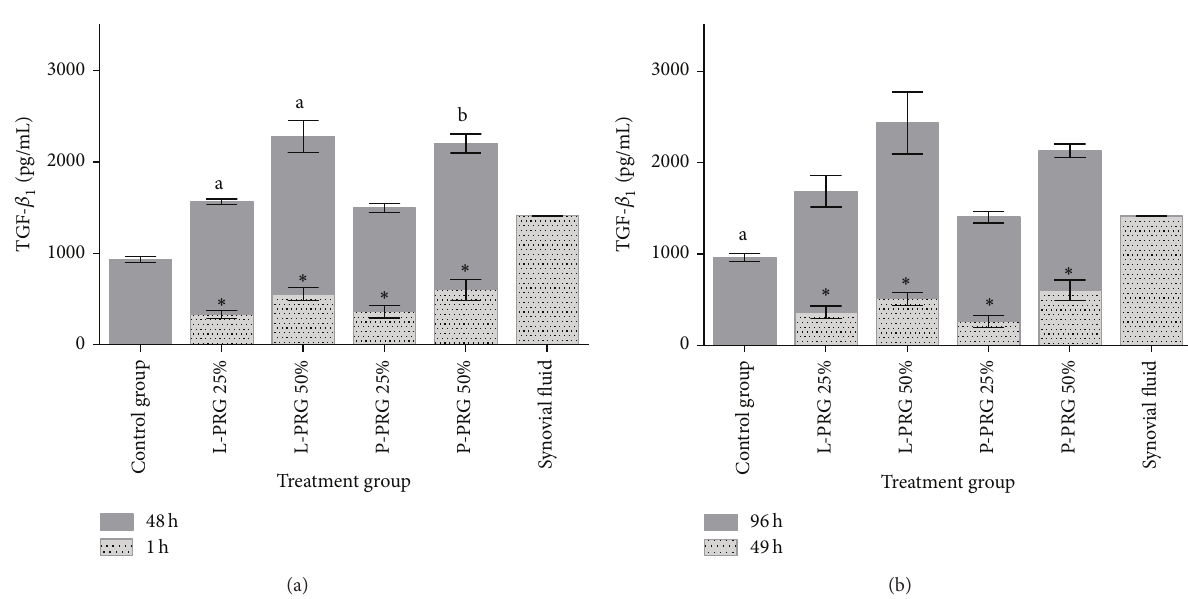
Figure 1: (a) a-b Lowercase letters denote significant ( 𝑃 < 0.05 ) differences between groups in the same column by Tukey test at 48 h. Significantly different with a: L-PRG 50% and P-PRG 50% and b: L-PRP 50%. (b) a Lowercase letters denote significant ( 𝑃 < 0.05 ) differences between groups in the same column by Tukey test at 96h. Significantly different with a: L-PRG 50%. ∗ Significant differences ( 𝑃 < 0.01 ) between the same variable at 1 h and 48 h and at 49 h and 96 by 𝑡 -paired test.